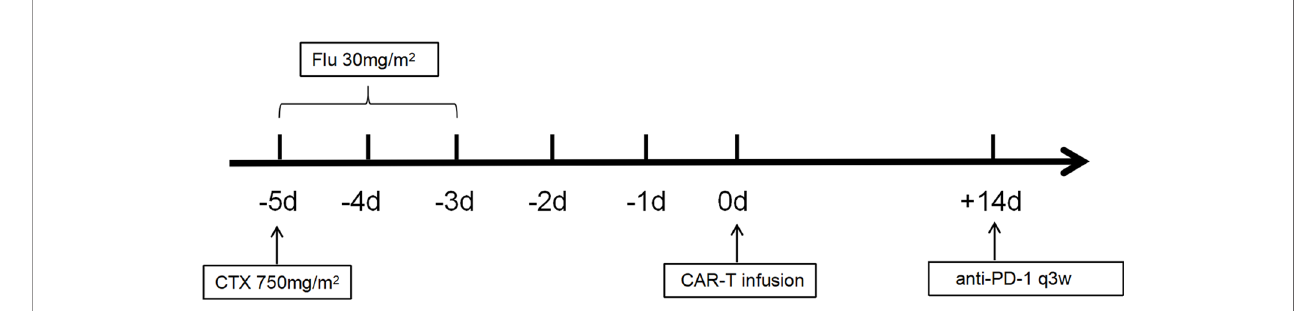
FIGURE 1 | Flowchart for anti-CD30